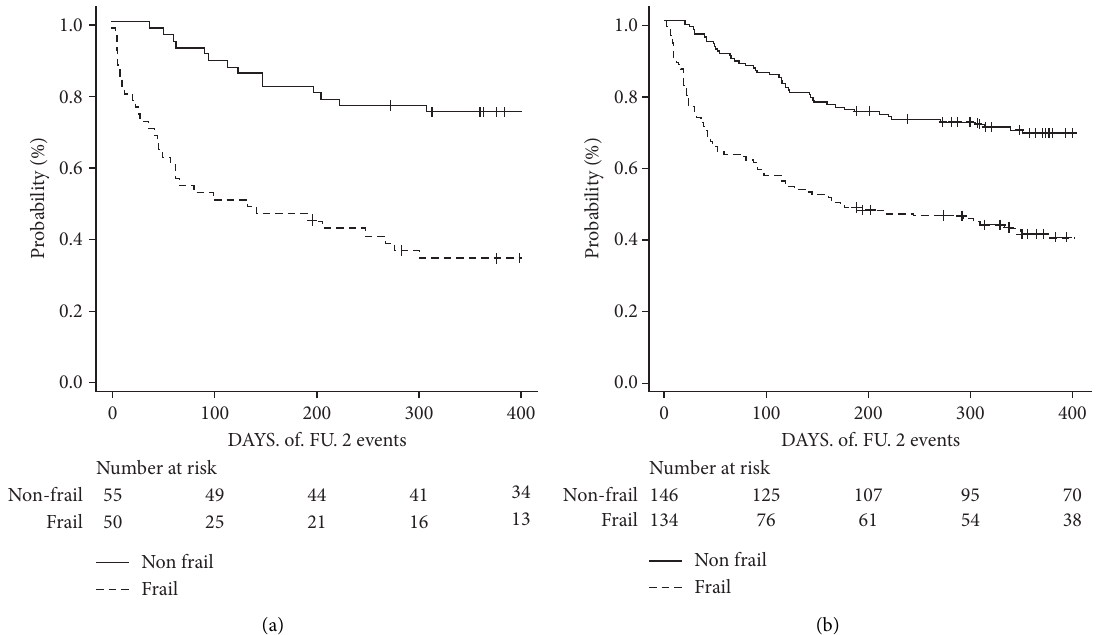
Figure 1: Kaplan–Maier transplant-free survival probability curves and a log-rank test by frailty status, solid line LFI ≤ 4.5, and dotted line LFI > 4.5, in alcoholic cirrhosis (right pane) and NAFLD cirrhosis (left pane), ∗ p < 0 . 0001. (a) NAFLD cirrhosis ∗ . (b) ALD cirrhosis.